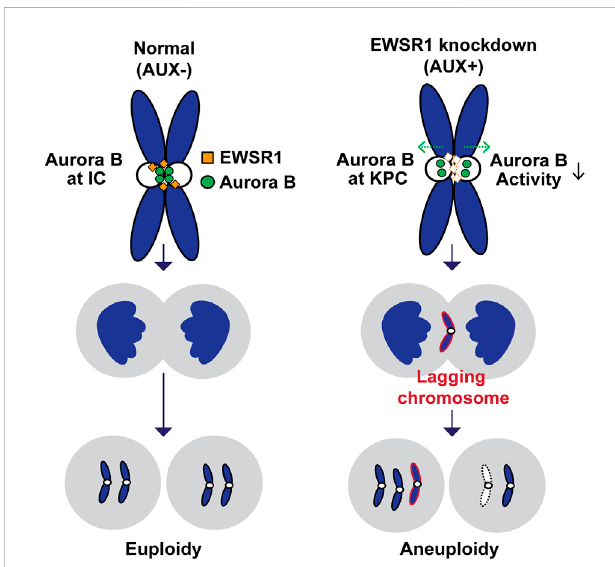
FIGURE 8 Schematic model of the study. The EWSR1 knockdown leads to the increased incidence of relocation of Aurora B from inner centromere to KPC (prometaphase and metaphase), of lagging chromosomes (anaphase), and of aneuploidy (after a single mitosis). Our data suggests that the EWSR1 prevents the induction of aneuploidy through interaction with Aurora B. Despite of the induction of chromosome mis- segregationinEWSR1knockdown cells,thecellsdonot arrestatmitosis, and it is likely that the cells are overriding the error collection